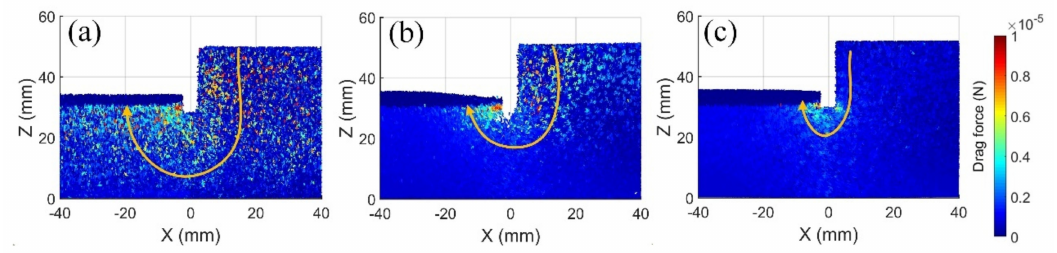
Figure 5. Distribution of drag force at t = 0.01 s for specimen ( a ) FC30; ( b ) FC40; and ( c )